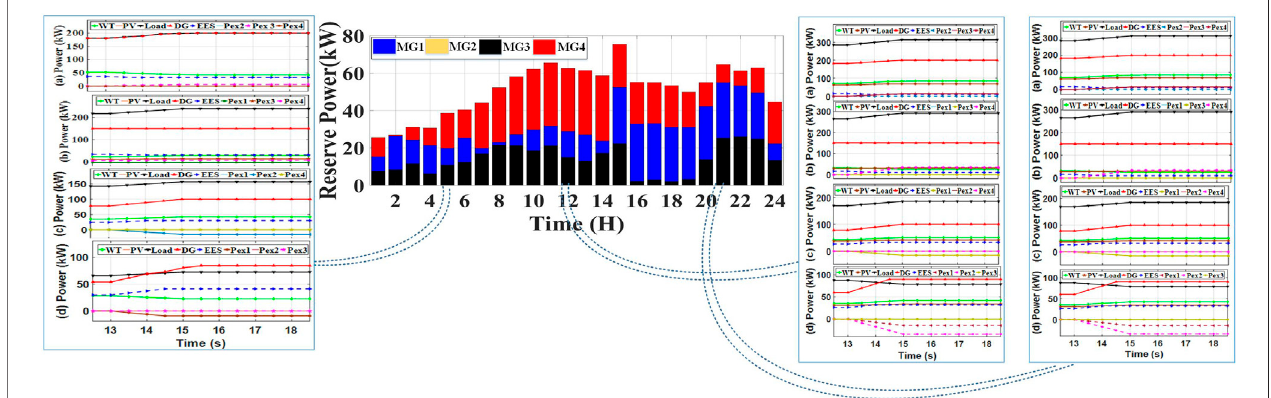
FIGURE 9 | Reserve sharing in the fi fth, 12th, and 21st hours.